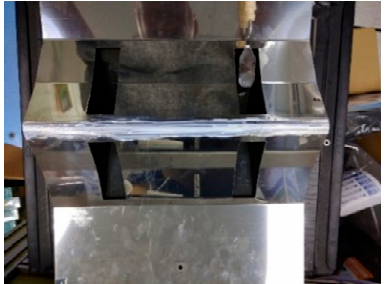
Figure 12. Coated TiO 2 on bird-wing optical reflector.